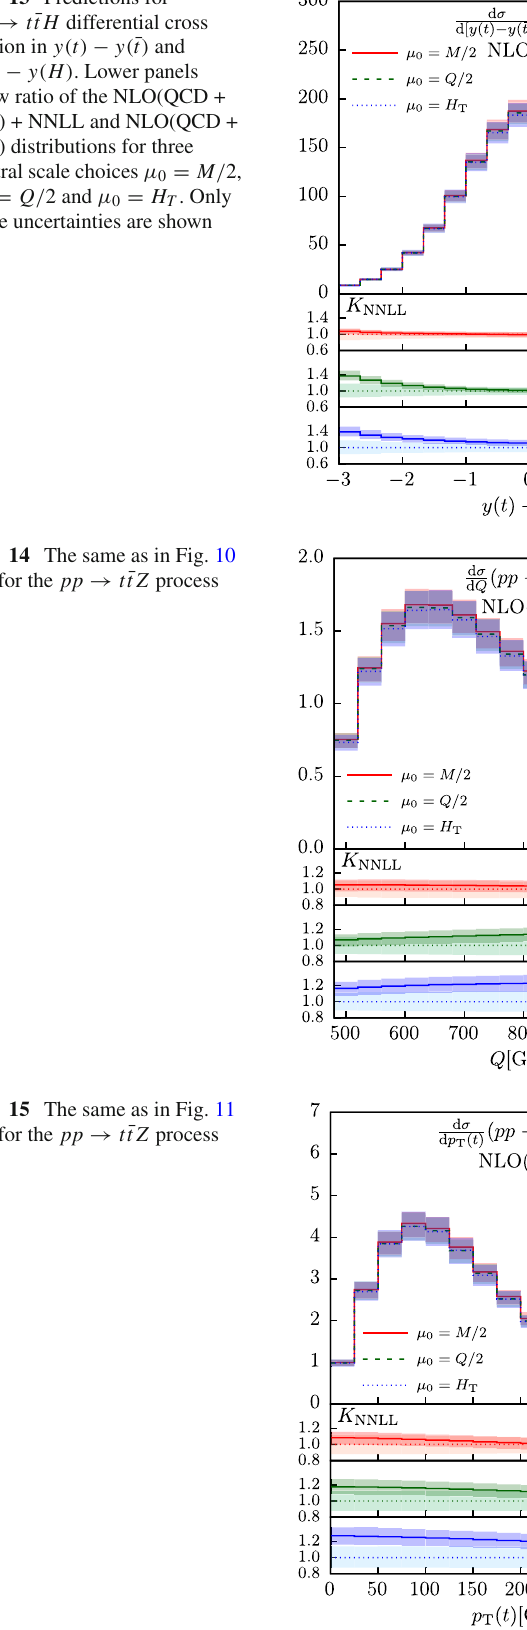
Fig. 15 The same as in Fig. 11 but for the pp → t ¯ tZ